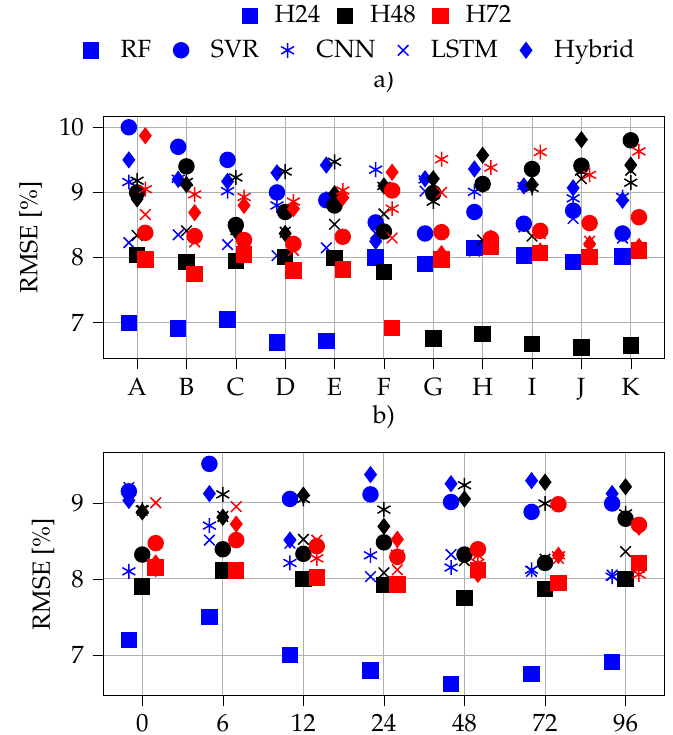
Figure 10. Top combinations: features ( a ); previous samples ( b